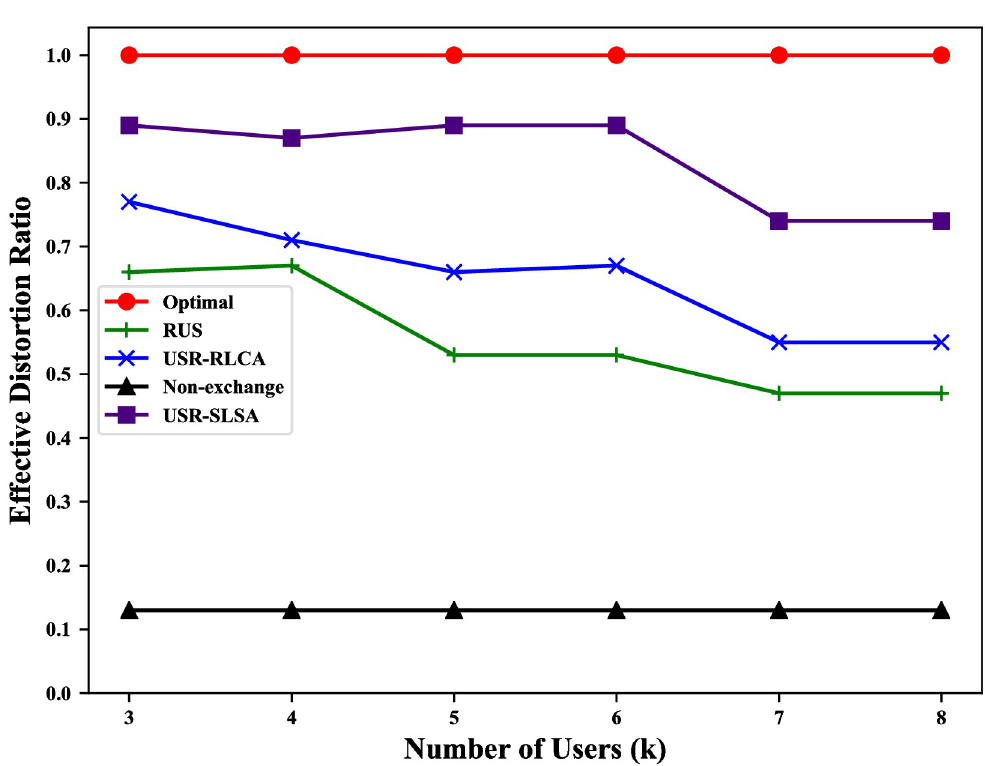
Fig 5. Impact of k on the privacy-preserving